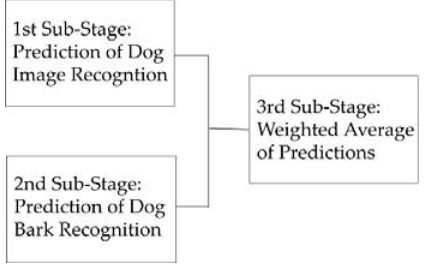
Figure 8. Three sub-stages to predict dogs’ behavior.